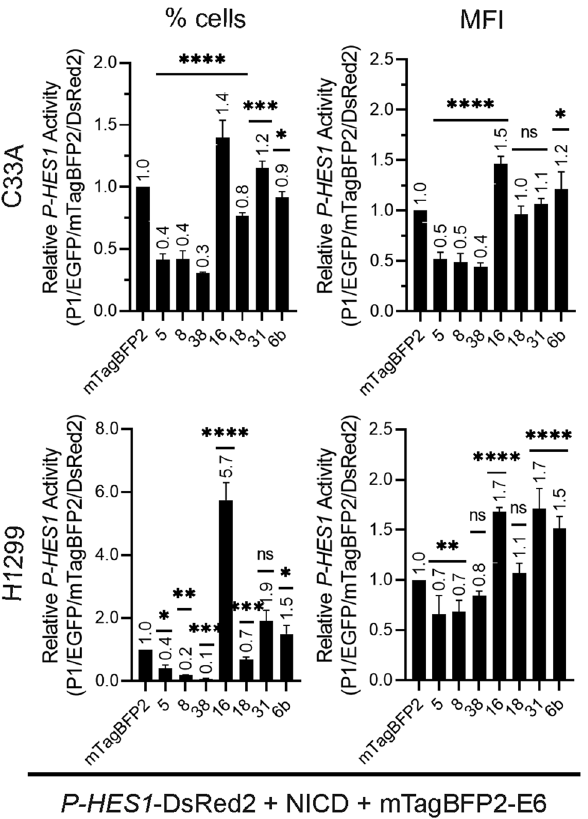
Figure 8. HPVE6 influence on P-HES1 promotor activity. The influence on P-HES1 promotor activity was analyzed by the triple gating strategy and signals for % cells (left) and mean fluorescence intensities of DsRed2 per cell (MFI, right) were plotted. Cell were co-transfected with 250 ng P-HES1 -DsRed2 reporter plasmid, 250 ng activator NICD plasmid and 125 ng mTagBFP2 or 500 ng of respective mTagBFP2-E6. FACS measurement was carried out 48 h or 36 h post transfection for C33A and H1299 cells, respectively. Compared to the negative control (mTagBFP2 not fused to E6), E6 of beta HPV types 5, 8 and 38 inhibit DsRed2 expression in both cell lines. E6 of the alpha HPV type 16 clearly upregulates expression of DsRed2 in both cell lines. E6 of the alpha-HPV31 and 6 show a slight activation in C33A and a more pronounced activation in p53-null cell line H1299. 18E6 shows no significant effect, rather slight repressing effect in % cells in both cell lines. Data plotted are the mean values of three independent biological replicates. The number above bars are the respective mean value. The error bars plotted are the standard deviation of the mean value from three independent biological replicates. P-values were calculated using One-Way ANOVA with Fischer’s LSD test by comparing the mean of each activation and repression sample with the control activation sample from three independent experiments where * = P ≤ 0.05, ** = P ≤ 0.01, *** = P ≤ 0.005, **** = P ≤ 0.0001, ns = P >